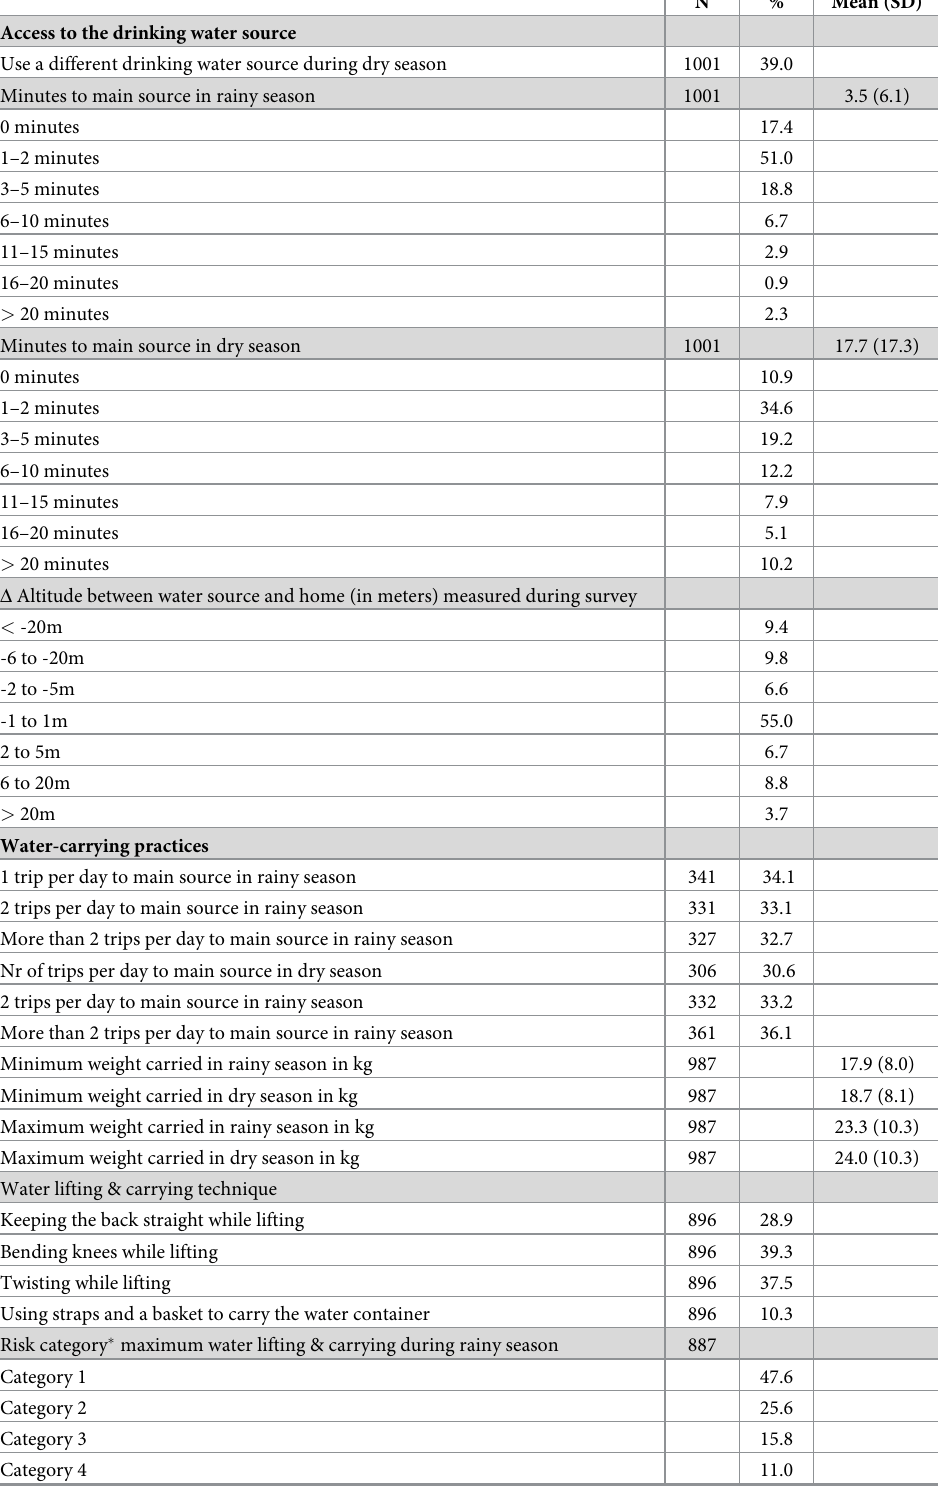
Table 2. Access to water source and water-carrying